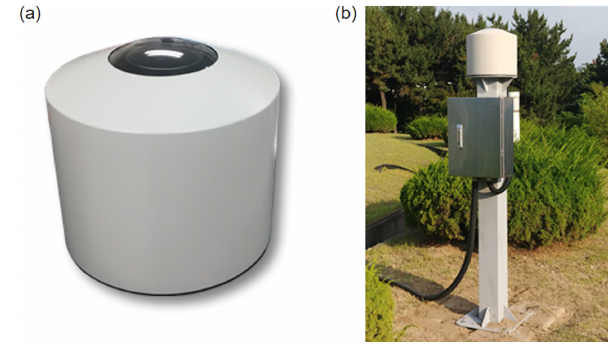
Figure 1. ACOS appearance (a) and installation environment (b) (Kim and Cha, 2020). Table 1. Detailed ACOS